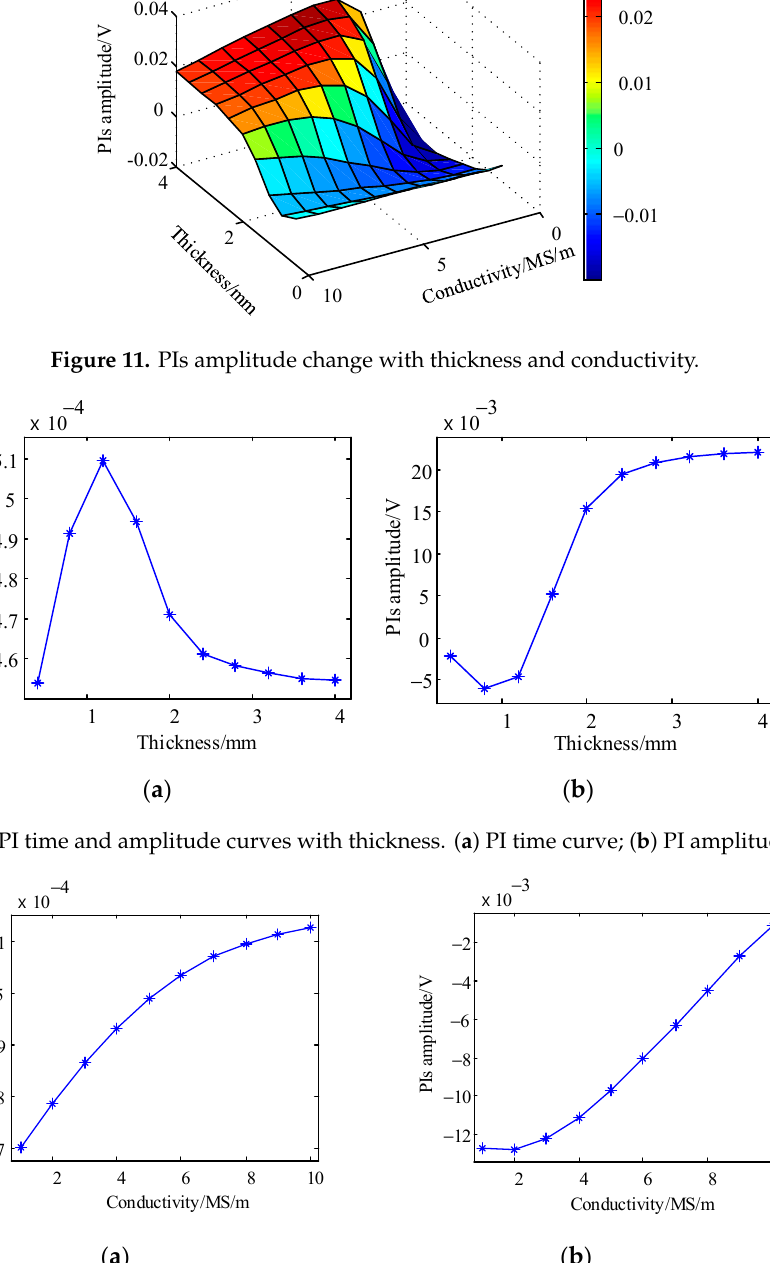
Figure 13. PI time and amplitude curves with conductivity. ( a ) PI time curve; ( b ) PI amplitude curve.